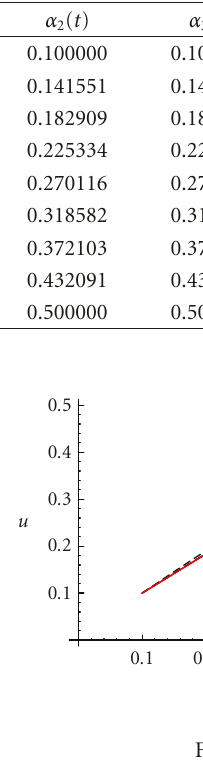
Table 4.2. Table of three α , β -iterates of